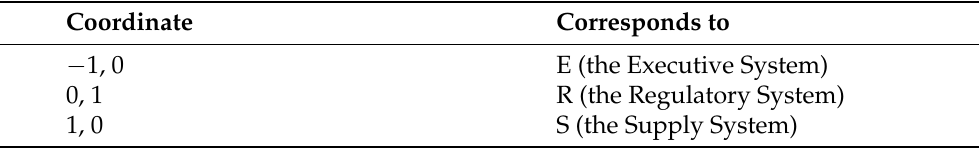
Table 4. Coordinates corresponding to the model of integral